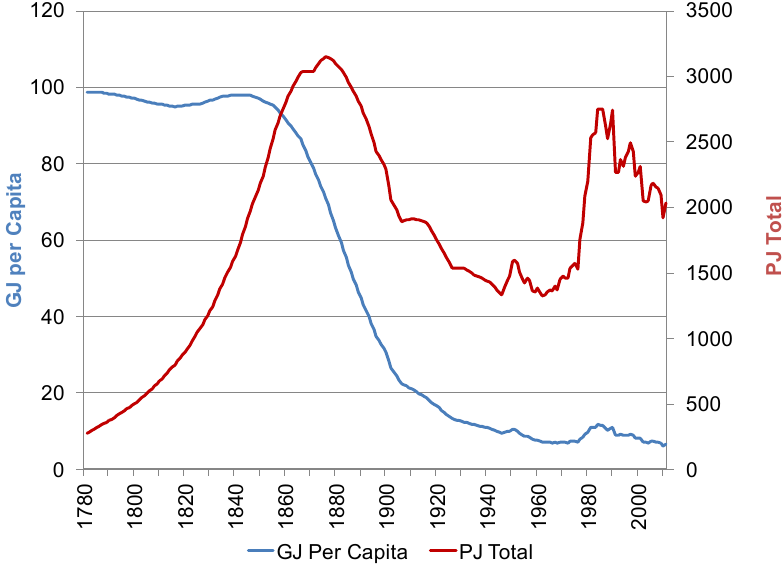
Figure 4. U.S. fuel wood consumption, 1780–2010. Sources: [33] and